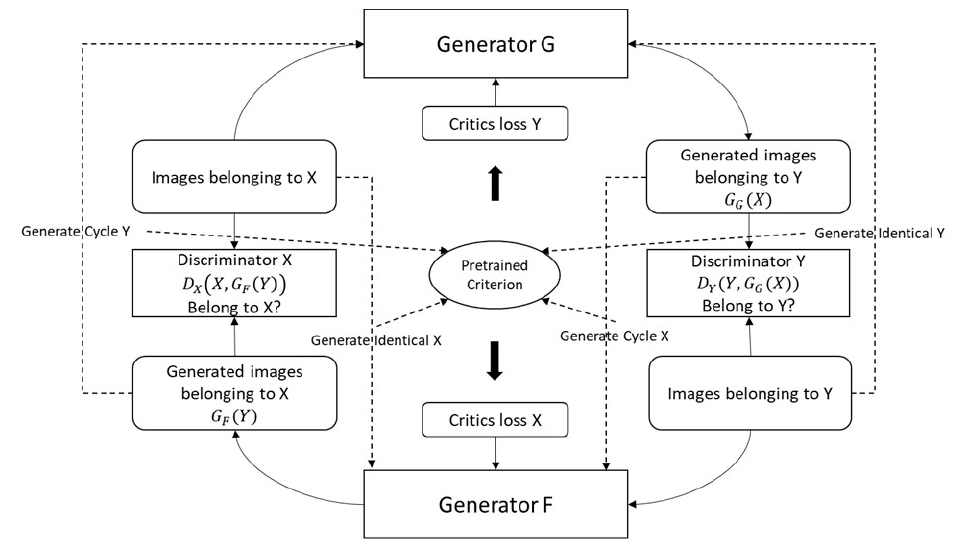
Figure 1. Ad CycleGAN Architecture.